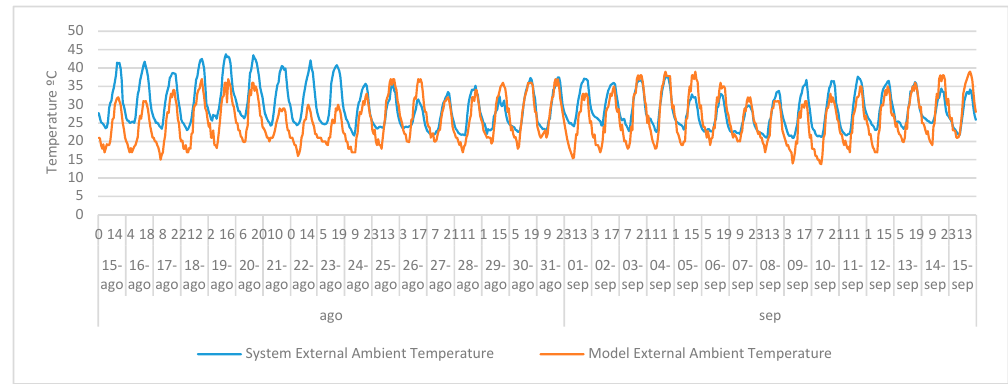
Figure 9. Exterior temperature for the system and the model.